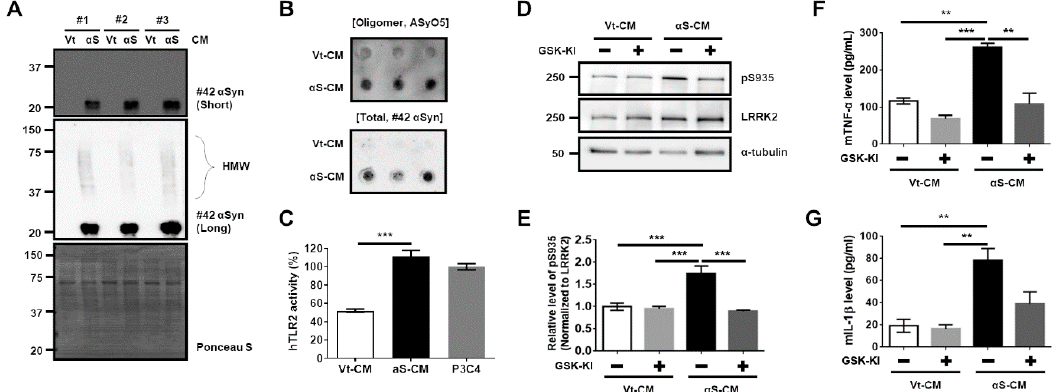
Figure 2. LRRK2 inhibitor hinders the LRRK2 activity and mTNF α release via the release of TLR2- specific α Syn from differentiated SH-SY5Y (dSH). The analyses of conditioned media of vector -transfected dSH (Vt-CM) and Flag- α Syn-transfected ( α S-CM) using Western blotting ( A ) or dot- blot analysis ( B ) revealed an oligomeric formation of α Syn in α S-CM. The high molecular weight Flag- α Syn oligomer (HMW) band is indicated by the open curly bracket. # indicates a number of n . ( C ) The hTLR2 activity was higher in the treated α S-CM than in the treated Vt-CM. ( D , E ) The effect of the treatment of Vt-CM and α S-CM with or without GSK-KI for 18 h on BV2 was analyzed using Western blotting. The released levels of mTNF α ( F ) and mIL-1 β ( G ) in the media were measured from ( D ). n = 3. ** p < 0.01 and *** p < 0.001. All data are represented as the mean ±